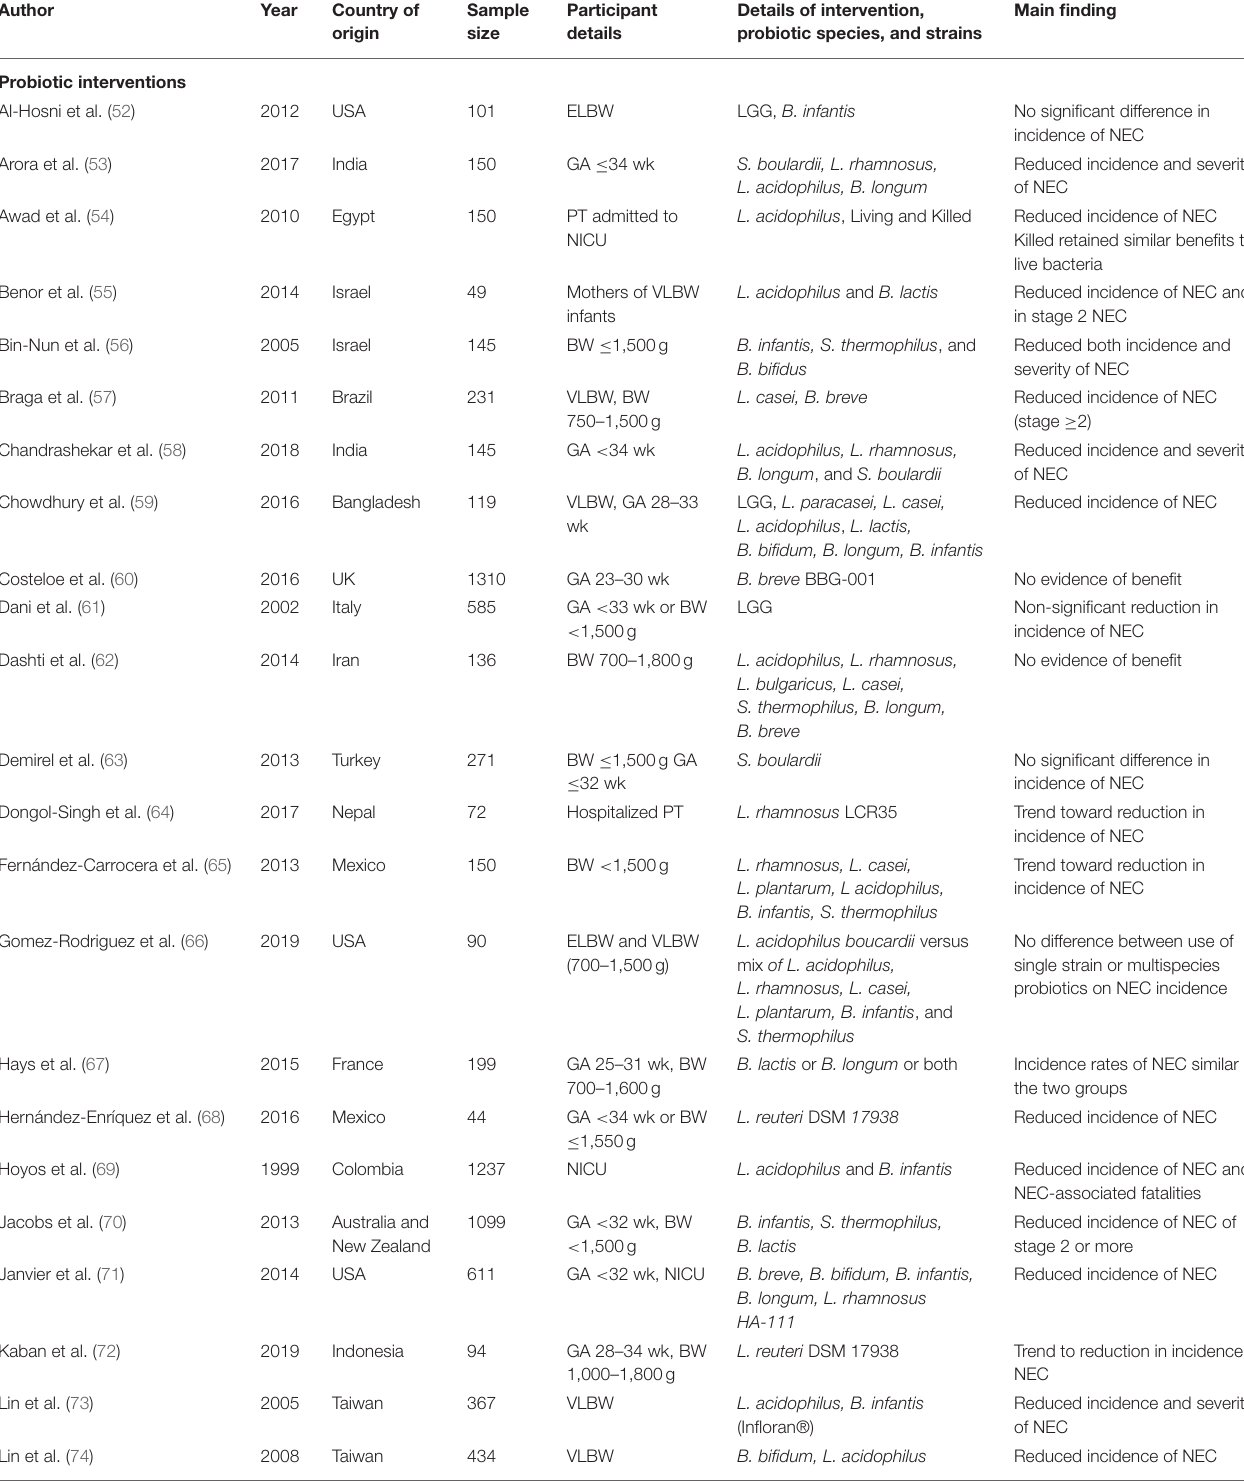
TABLE 1 | Characteristics of randomized controlled trials evaluating probiotics, prebiotics, and synbiotics for